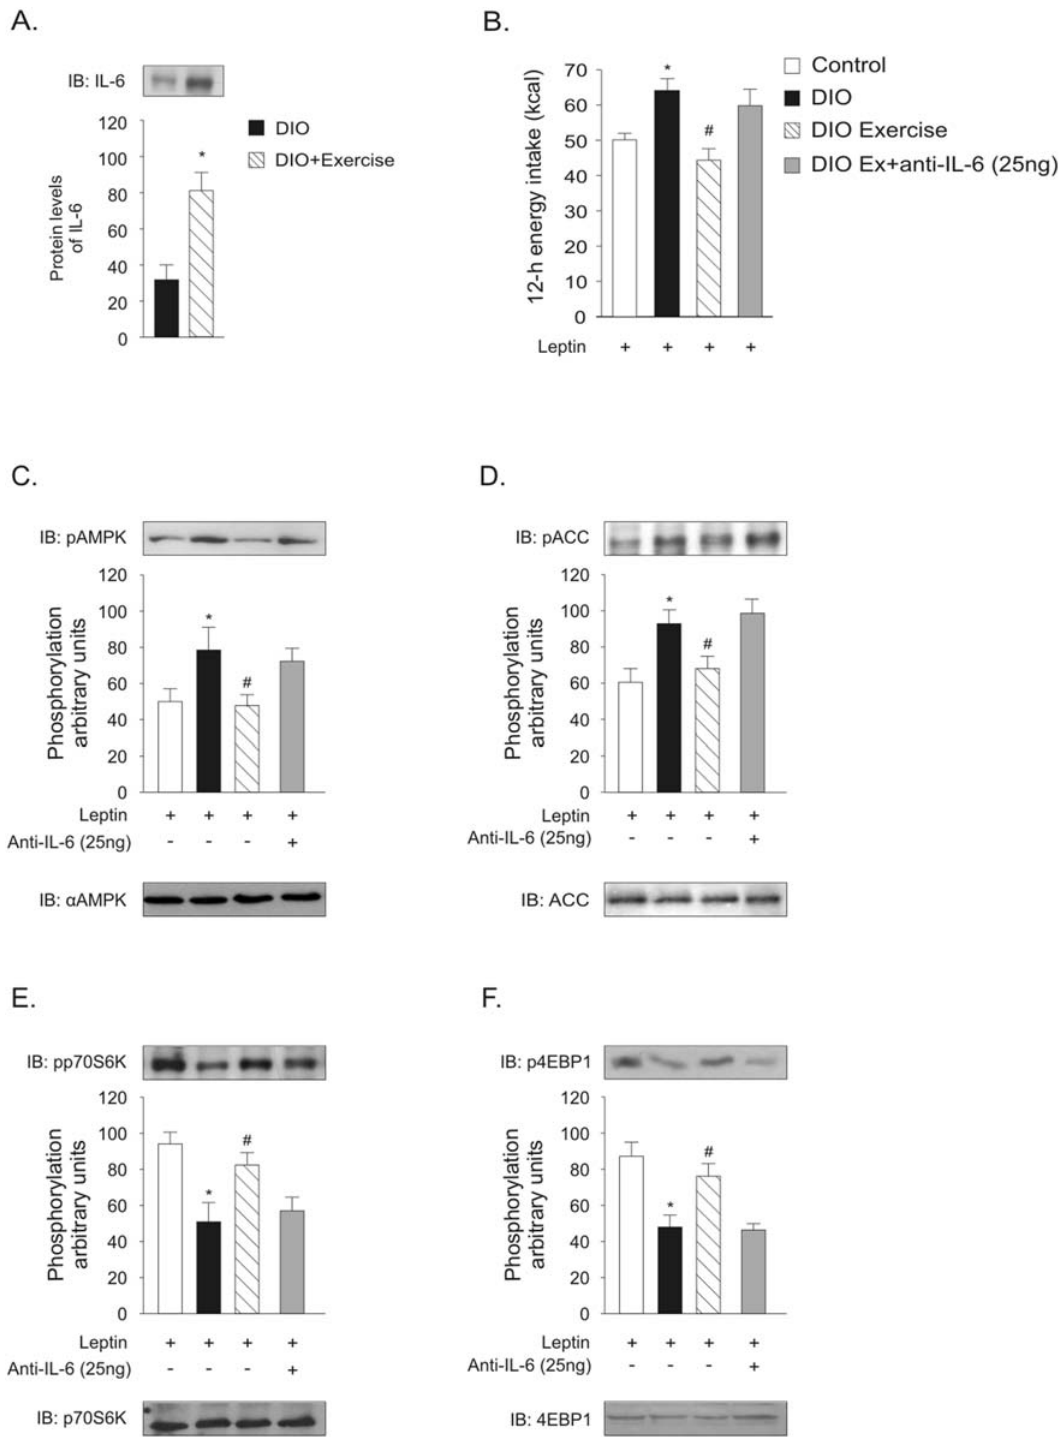
Figure 7. Leptin effects on 12-h cumulative food intake and AMPK/mTOR signaling in the hypothalami of control, DIO and exercised DIO rats. (a) Representative Western blots of five independent experiments showing hypothalamic IL-6 expression in DIO Wistar rats at rest and immediately after acute exercise. (b) Leptin (10 2 6 M) was administered in control, DIO and exercised DIO rats. Animals were immediately exposed to food for a 12-hour period ( n =12–15 animals per group). (c, d, e and f) Representative Western blots of five independent experiments showing hypothalamic lysates from Wistar rats. Phospho-AMPK thr172 , threonine-phosphorylated AMPK and total AMPK (c); phospho-ACC ser79 , serine phosphorylated ACC and total ACC (d); phospho-p70S6Kinase thr389 , threonine phosphorylated p70S6Kinase and total p70S6K (e); phospho-4EBP1 thr70 , threonine phosphorylated 4EBP1 and total 4EBP1 (f). Data are the means 6 SEM. * p , 0.05, vs. control group, # p , 0.05, vs. DIO group.